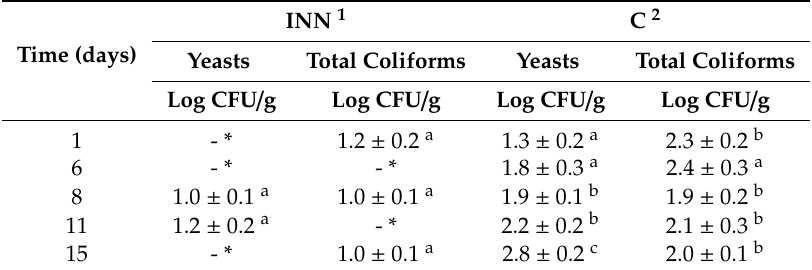
Table 3. Cell load (Log CFU / g) of yeasts and total coliforms, in innovative and traditional Squacquerone cheeses during refrigerated storage. At the same time of storage, means ± SD followed by di ff erent superscript letters ( a–c ) are significantly di ff erent, p < 0.05.